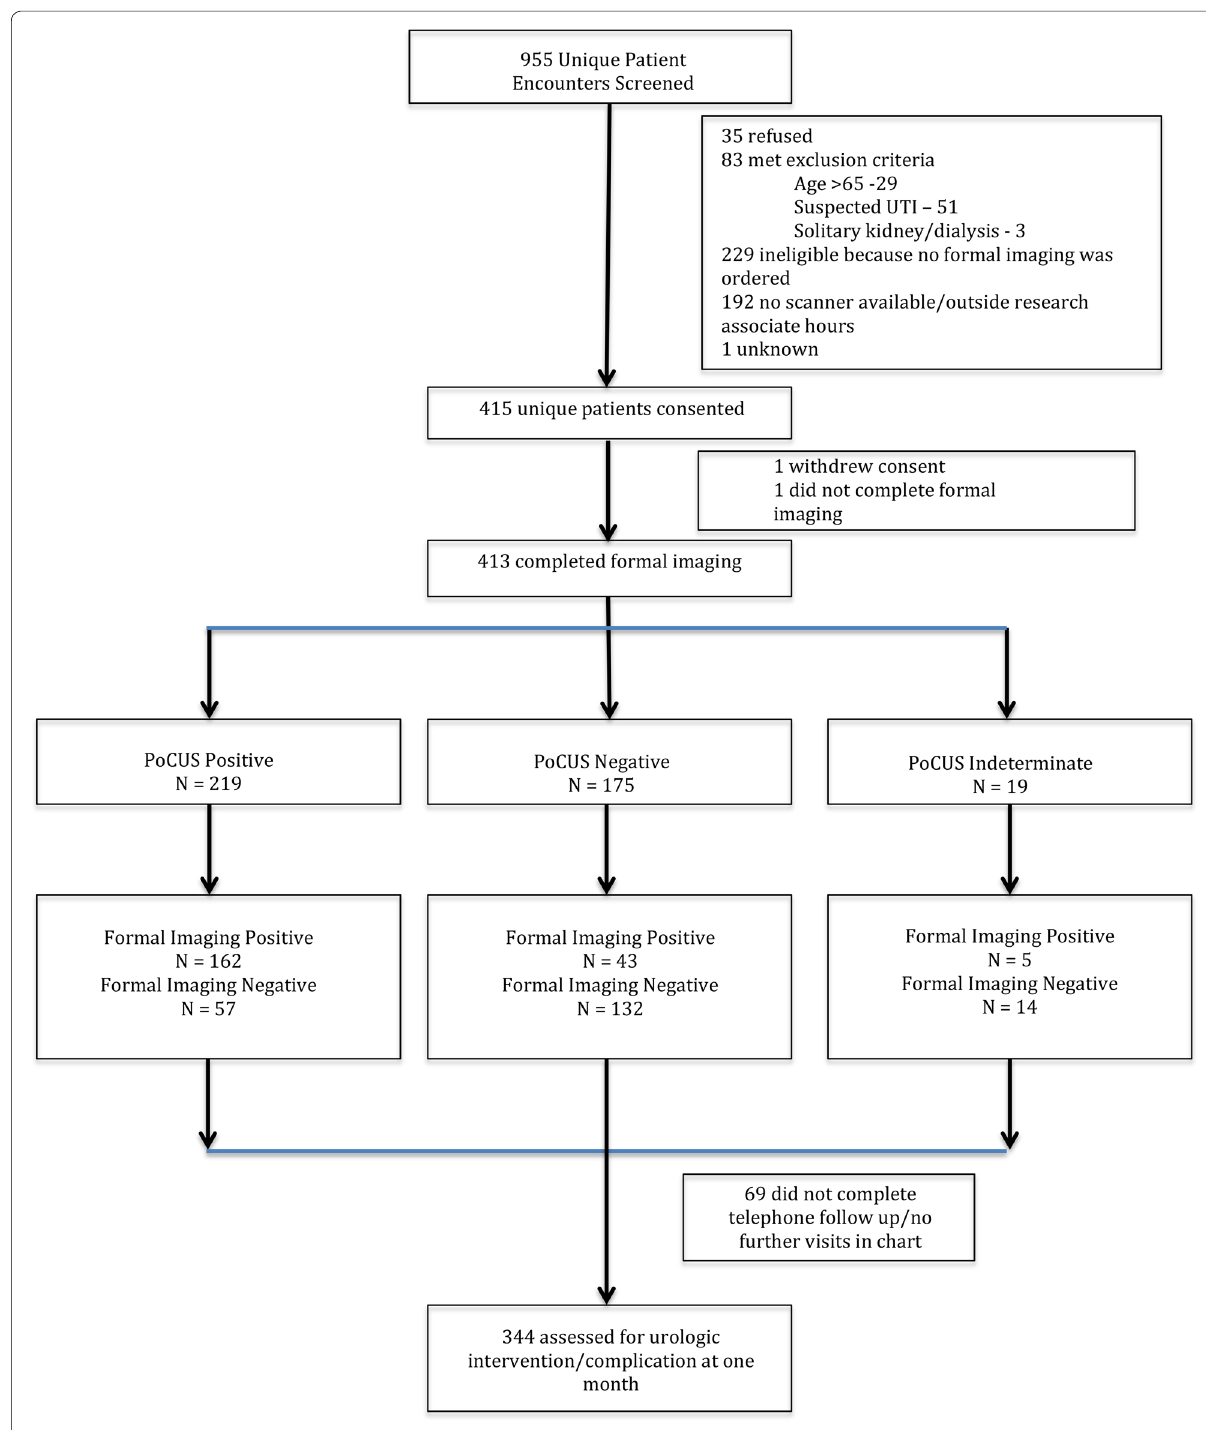
Fig. 1 STARD flow diagram of patient enrollment and